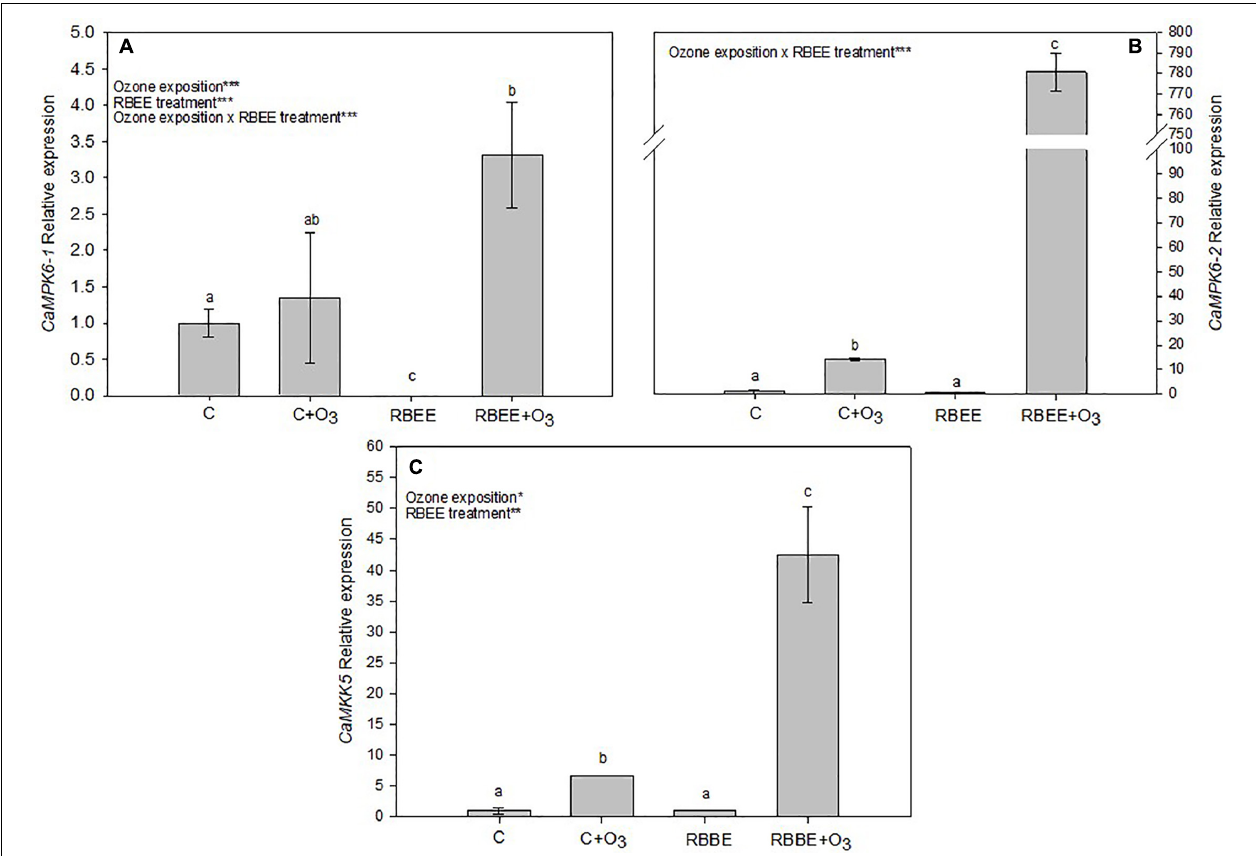
FIGURE 5 | Relative expession of (A) CaMPK6-1 , (B) CaMPK6-2 , and (C) CaMKK5 in leaves of pepper plants in response to two conditions of ozone (O 3 ) (0 and 100 ppm) under a treatment without and with rice bran enzymatic extract (RBEE). For each gene, the expression level is relative to that of control plants (without RBEE treatment and without O 3 exposition) considered as 1. Values represent relative expression ± SD, n = 3. Different letters indicate means that are significantly different from each other (two-way ANOVA, O 3 exposition × RBEE treatment; HSD test, P < 0.05). O 3 exposition, RBEE treatment, and O 3 exposition × RBEE treatment in the corner of the panels indicate main or interaction significant effects (* P < 0.05; ** P < 0.001; *** P <